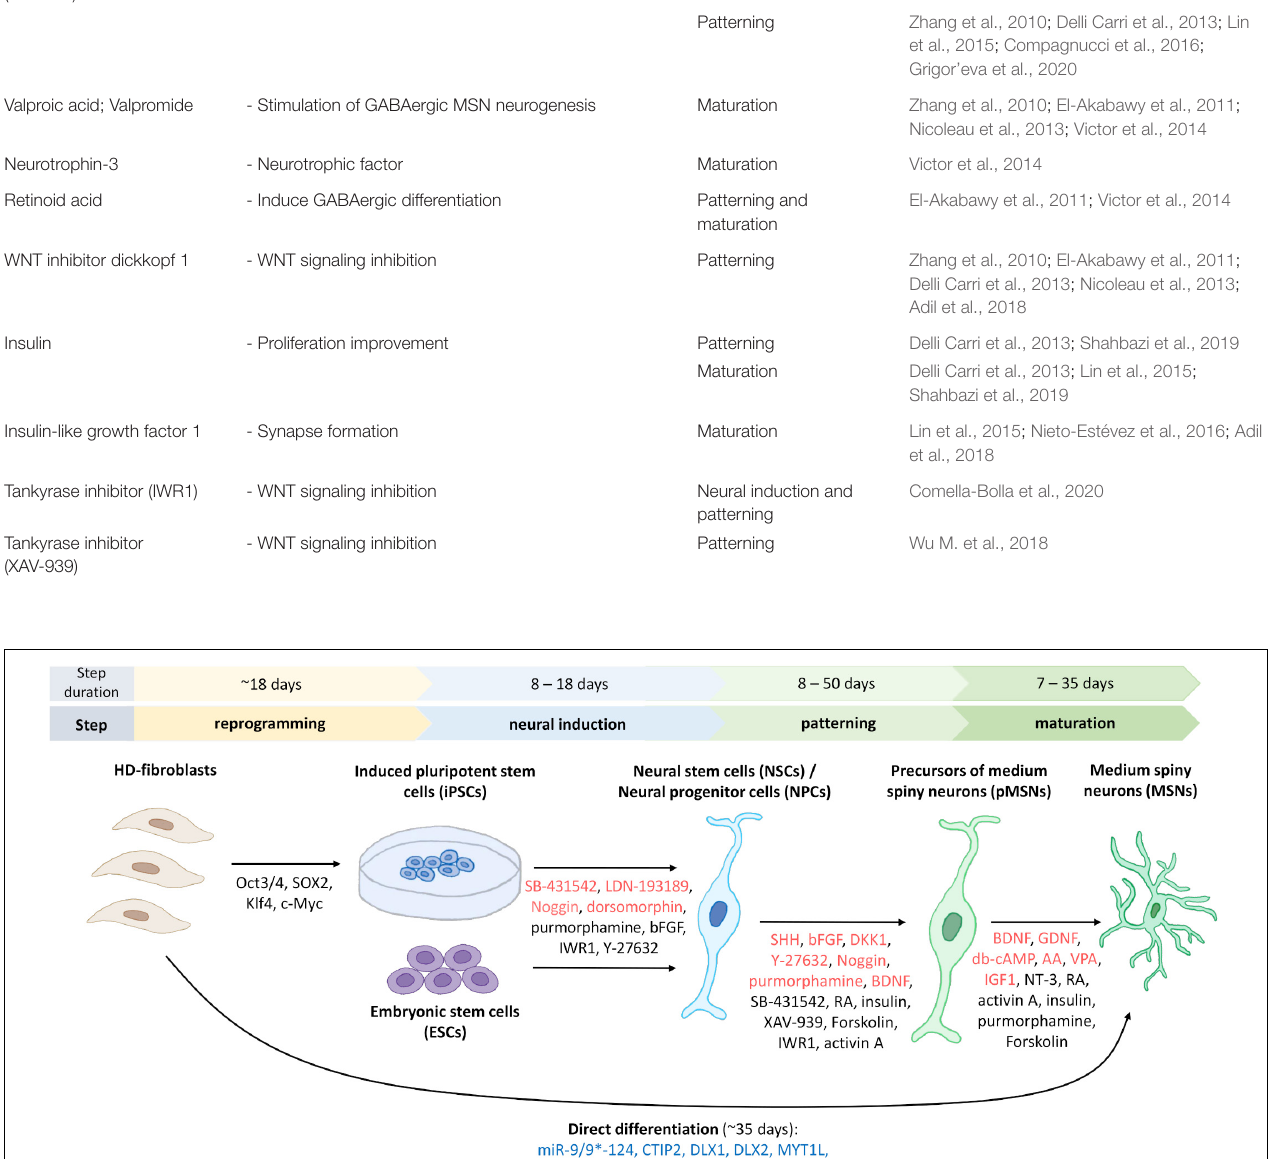
Frontiers in Cell and Developmental Biology |